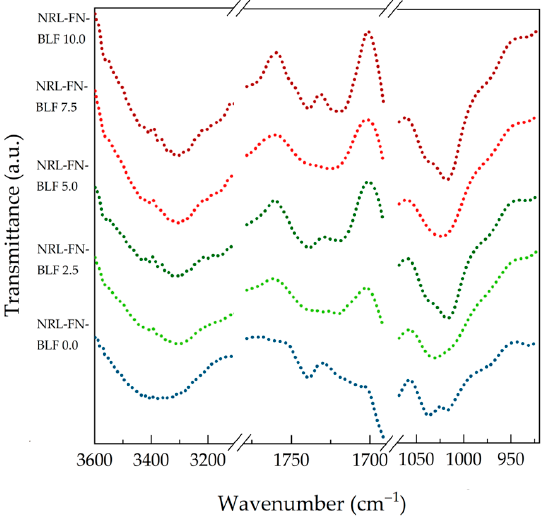
Figure 16. FTIR spectra of NRL foam composite at various BLF contents after soil burial for 24 weeks.